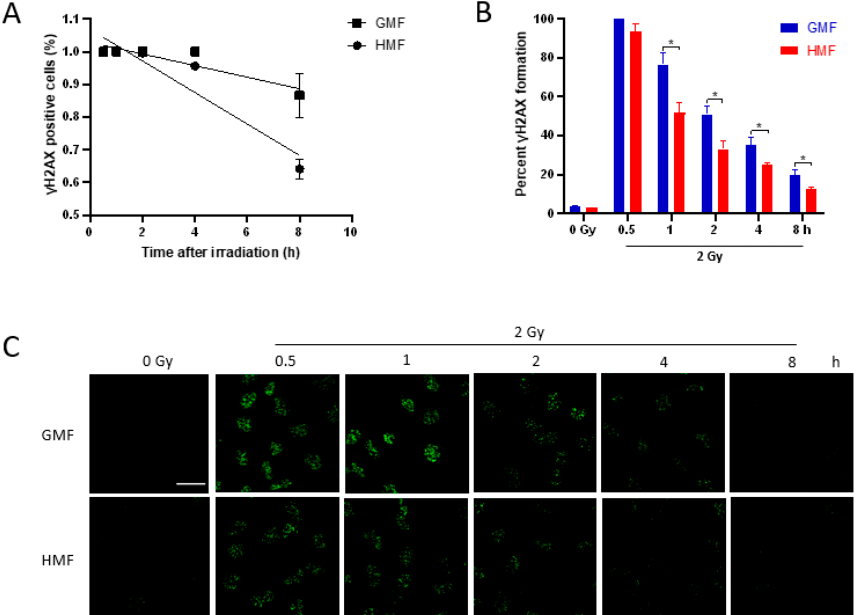
Figure 3. Kinetics of γ H2AX foci in BEAS-2B cells irradiated with 2 Gy of X-rays and incubated in HMF or in GMF before and after IR. ( A ) Percentage of cells positive for γ H2AX foci, determined by counting 200–250 cells for each experimental point. ( B ) Percentage of γ H2AX foci per nucleus; at least 150 cells/time-point were scored for foci. ( C ) Immunofluorescence of γ H2AX foci at 0.5, 1, 2, 4, and 8 h after irradiation. Results represent the mean of 3–4 independent experiments ± SEM (* p < 0.05, ANOVA), Scale bar = 30 μ m. Int. J. Mol. Sci. 2020 , 21 , x FOR PEER REVIEW